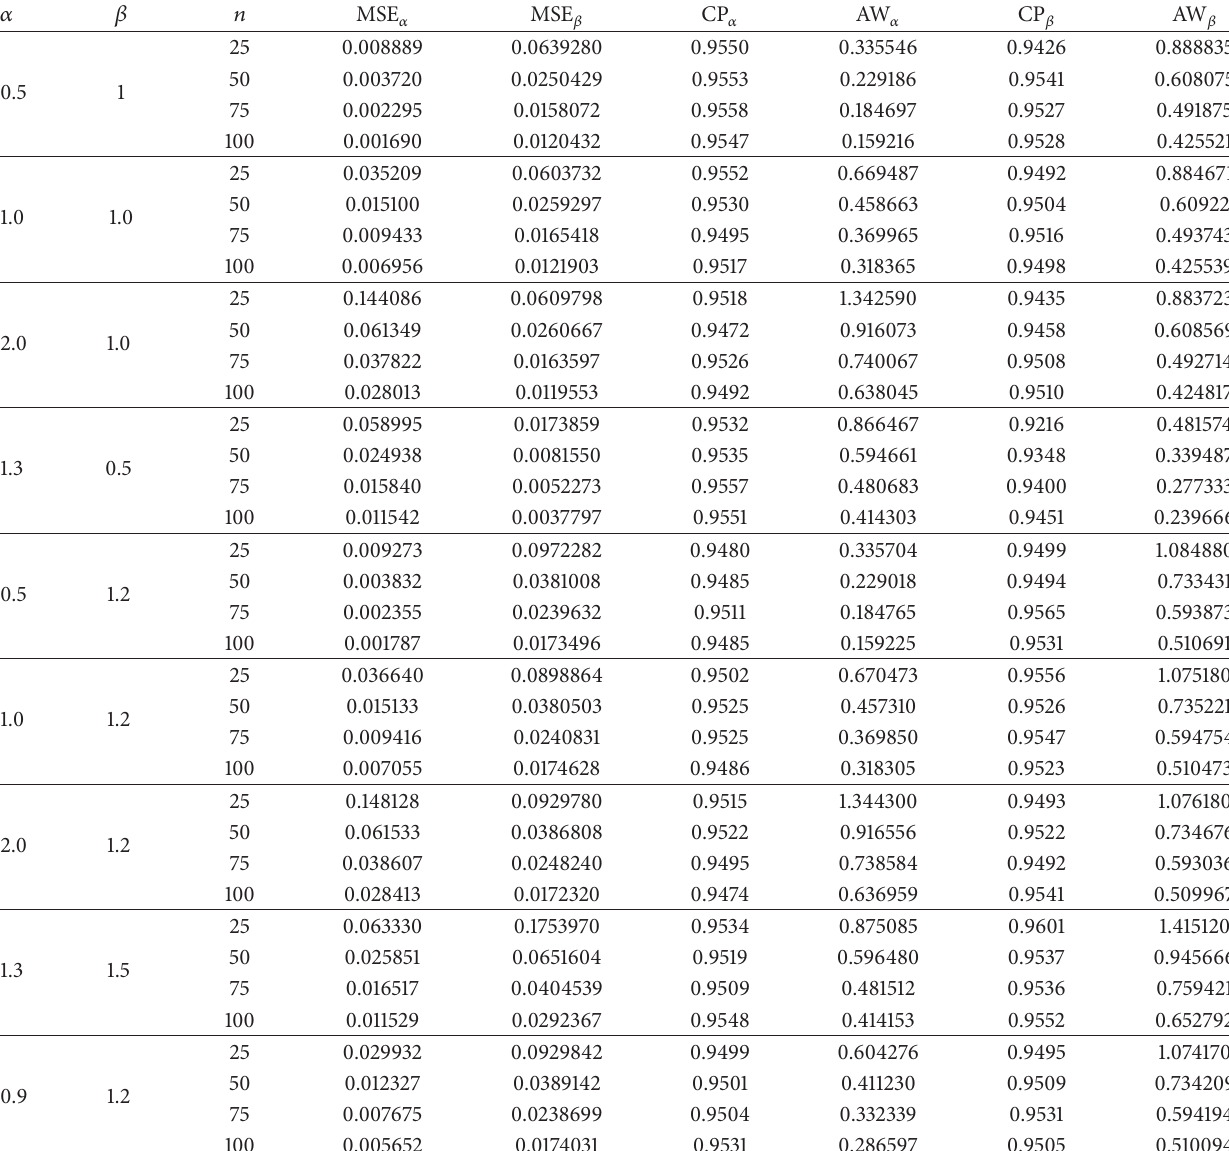
Table 4: MSE, coverage probability, and average